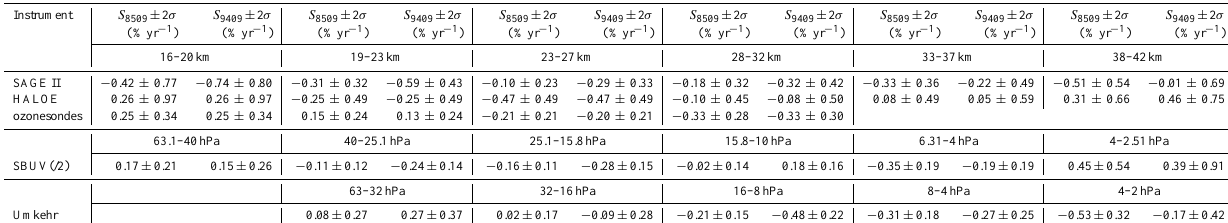
Table 3. The slope (S) and twice its standard deviation ( σ ) deduced from the monthly averages of the relative differences (%) at selected altitude levels for the periods 1985–2009 ( S 8509 ) and 1994–2009 ( S 9409 ). The two periods are chosen because of the upgradation of OHP lidar in 1993. Umkehr and SBUV(/2) are given on pressure levels.